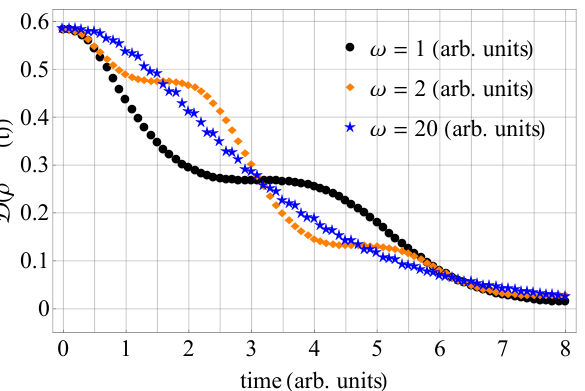
Figure 8. Plots present the Bures distance, D ( ρ ABC ( t )) , for three values of ω . Initially, the system was represented by the GHZ